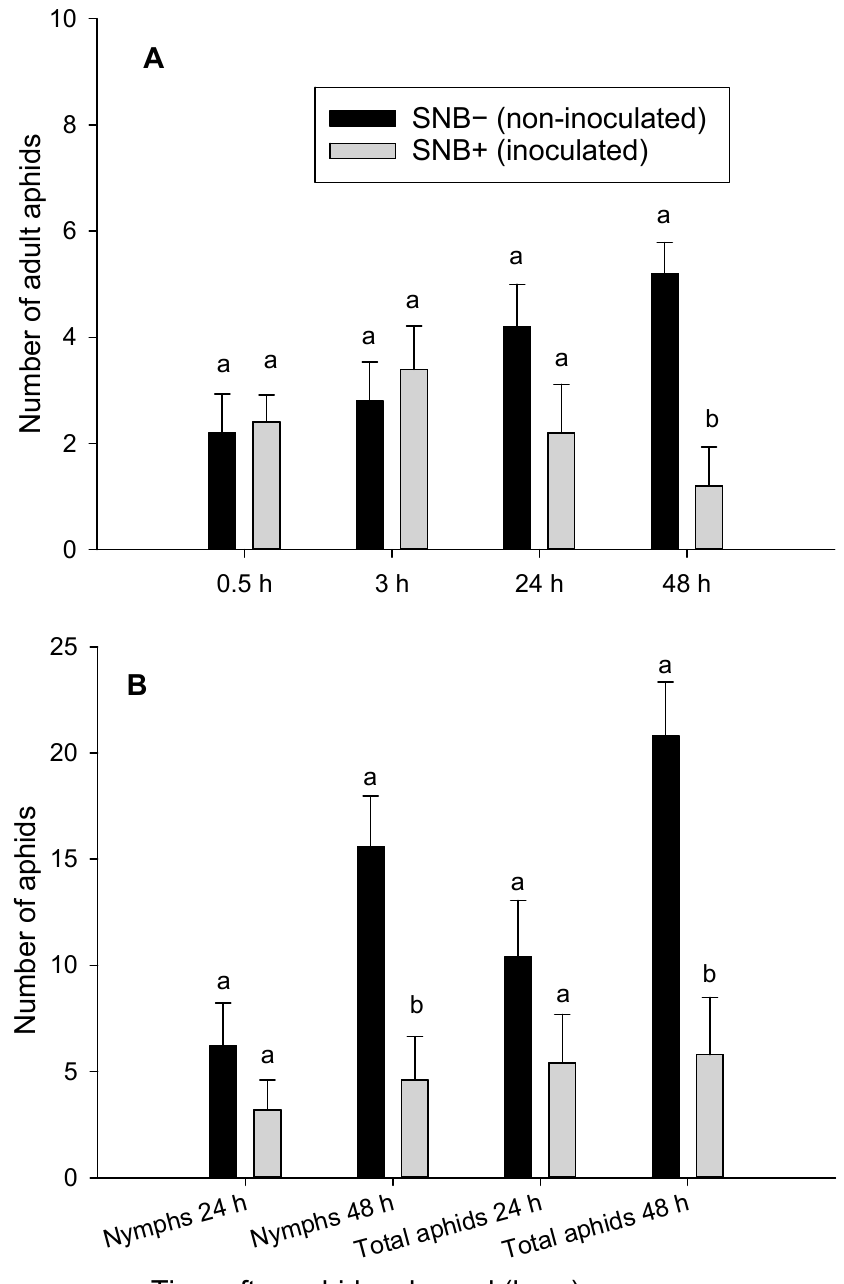
Figure 6. Number of adult aphids ( Rhopalosiphum padi ) ( A ) and number of adult aphids and nymphs ( Rhopalosiphum padi ) ( B ) on Stagonospora nodorum blotch inoculated (SNB+) and non-inoculated (SNB − ) leaves of the wheat 0.5, 3, 24 and 48 h after adult female aphid release. Results from experiment 2. Error bars are standard error of the mean values and bars with different letters within the same treatment group are statistically different at p = 0.05.